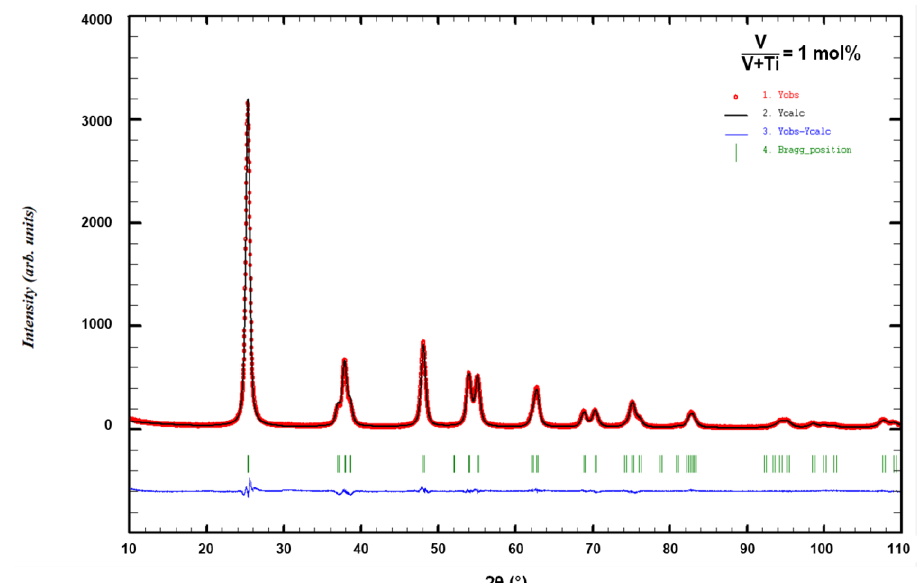
Figure 3. Rietveld refinement with TiO 2 anatase structural model of V-TiO 2 sample with 1 mol% V calcinated at 450 °C.